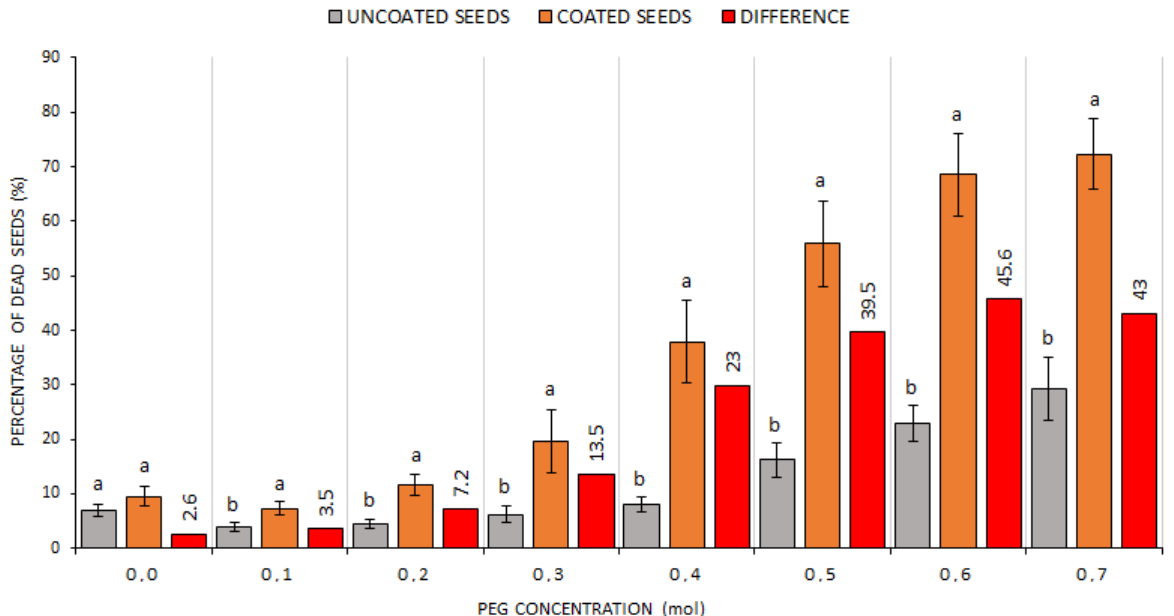
Figure 4. The comparison of dead seed percentages within US and CS treatments at different drought simulation degrees. Average values for all indicator plants for the US (uncoated seeds; n = 20 ± SE; average of all plant species) and CS (coated seeds; n = 20 ± SE; average of all plant species) treatments with PEG concentrations = 0.0 – 0.7 mol; different lowercase letters indicate significant difference (ANOVA post-hoc Tukey´s HSD test; p < 0.05) for the respective parameters between the US and CS groups.